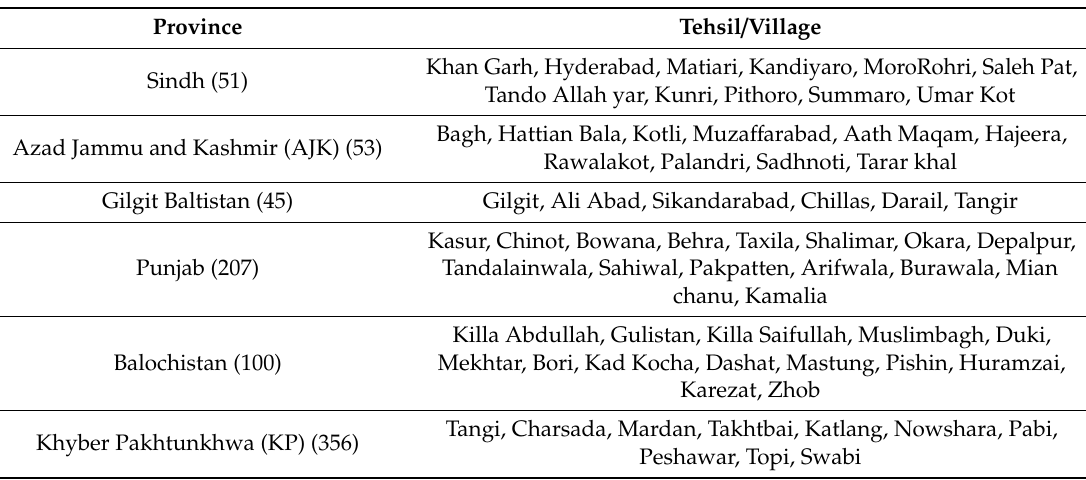
Table 2. Sample of Tehsil /